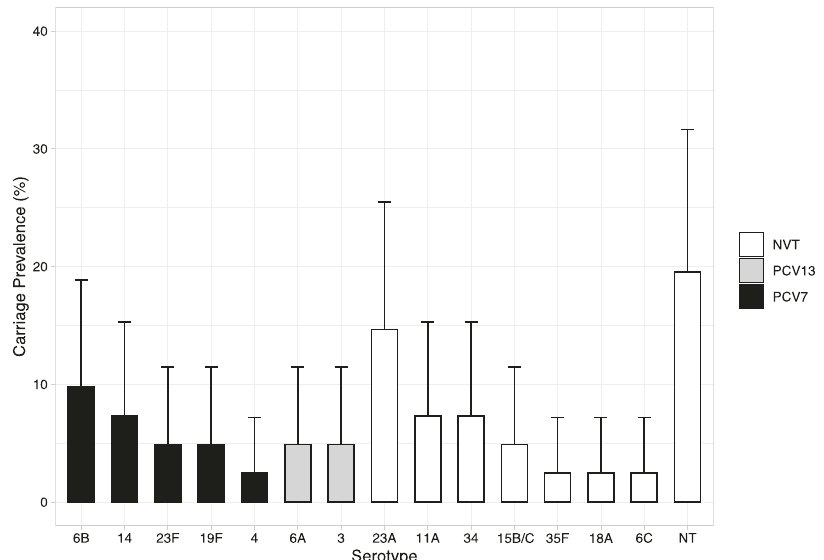
Fig. 3 Prevalence of PCV7, PCV13 and nonvaccine pneumococcal serotypes. Bar plot with 95% CI showing prevalence of serotypes that are included in PCV7 (black), additional types covered by PCV13 (grey) or nonvaccine serotypes